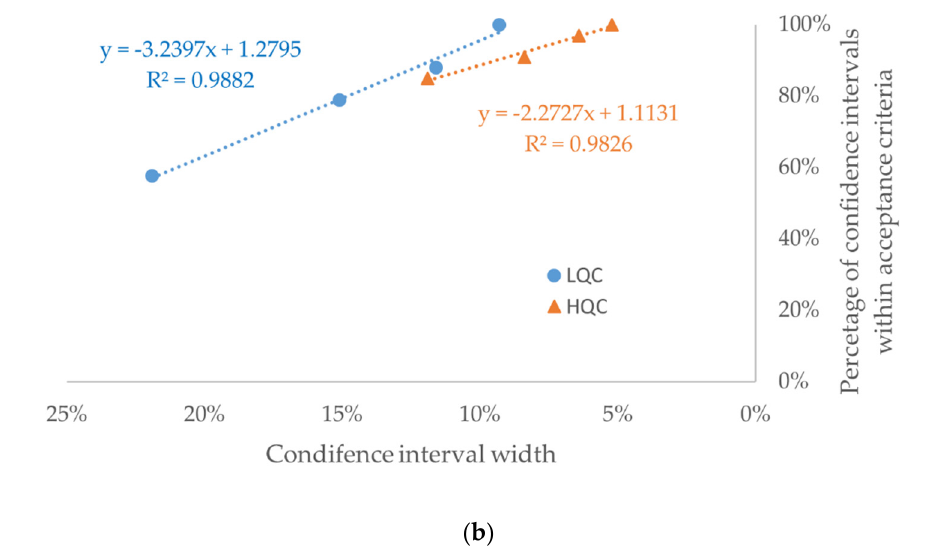
Figure 6. Retrospective study of nine drugs’ stability in human plasma: percentage of confidence intervals within acceptance criteria in the function of ( a ) number of samples and ( b ) mean width of the confidence interval for each number of samples (see Table 2). The dataset consisted of 33 confidence intervals for each concentration level: LQC (circle)—low-quality control sample; HQC (triangle)—high-quality control sample.